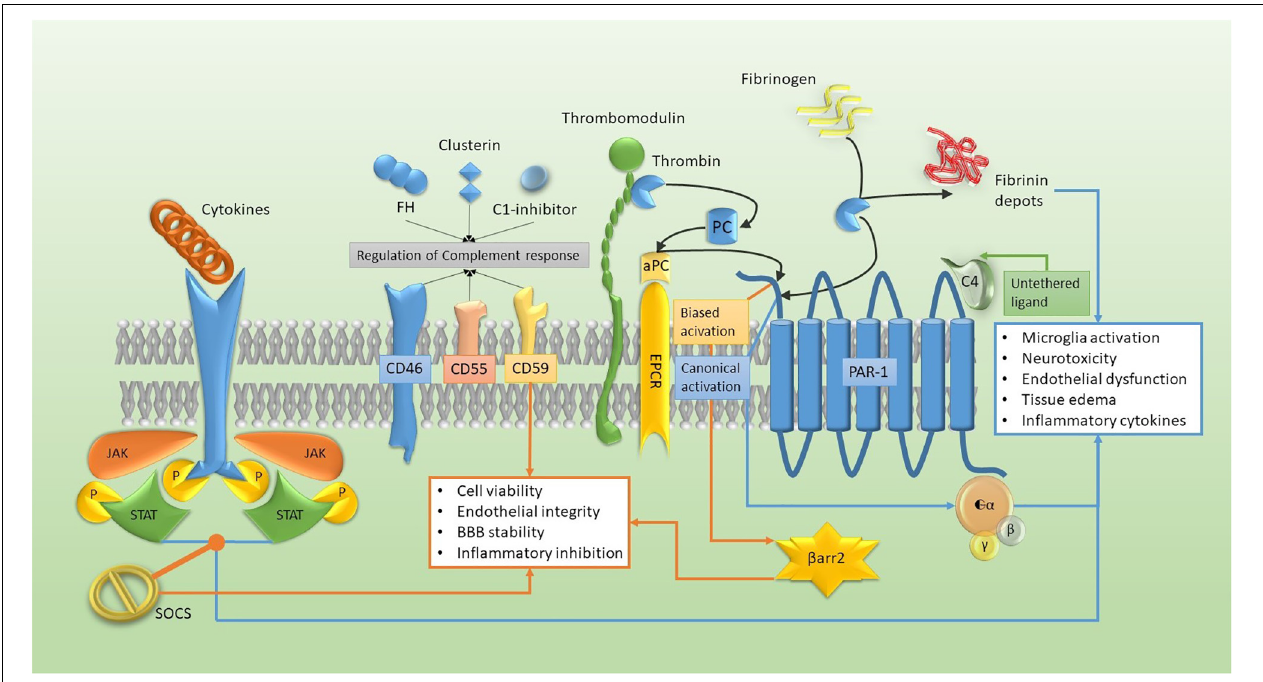
FIGURE 1 | Molecular pathways of the neuro-immune hemostasis model. Cytokine activation of JAK-STAT tyrosine kinase receptor can be turned off by SOCS expression and, together with the complement regulation and the biased activation of PAR-1/ β arrestin ( β arr2) (orange pathway), they enhance the adaptive response. The canonical activation of PAR1, together with tyrosine kinase receptor activation and the fibrin deposition (blue pathway), accelerate maladaptive cellular